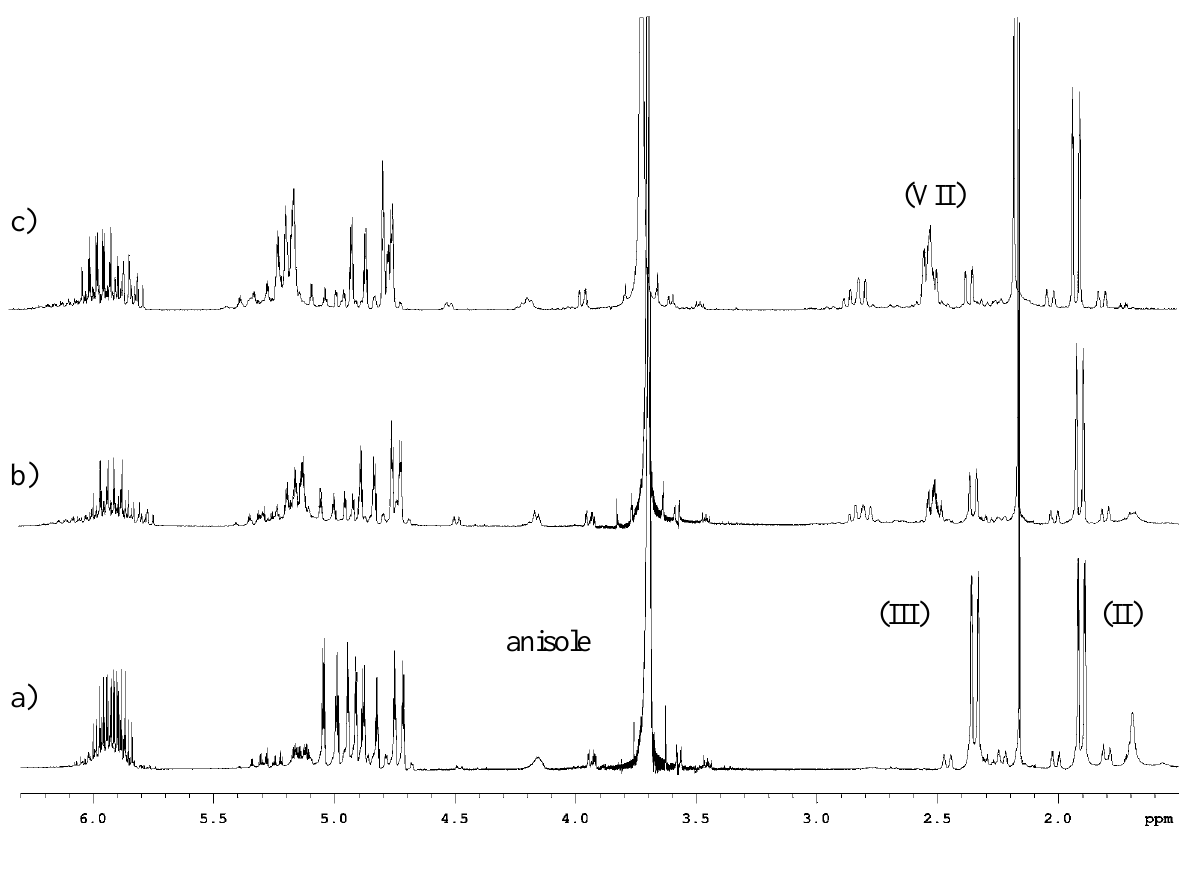
Figure 5 : Partial 1 H-NMR spectra in CDCl of the reaction of benzaldehyde and the 3 tetrallyltin and triallyltin bromide mixture. a) Before addition of the aldehyde; b) first addition of benzaldehyde; c) second addition. Assignments: tetrallyltin (II); triallyltin bromide (III) and alcohol homoallylic